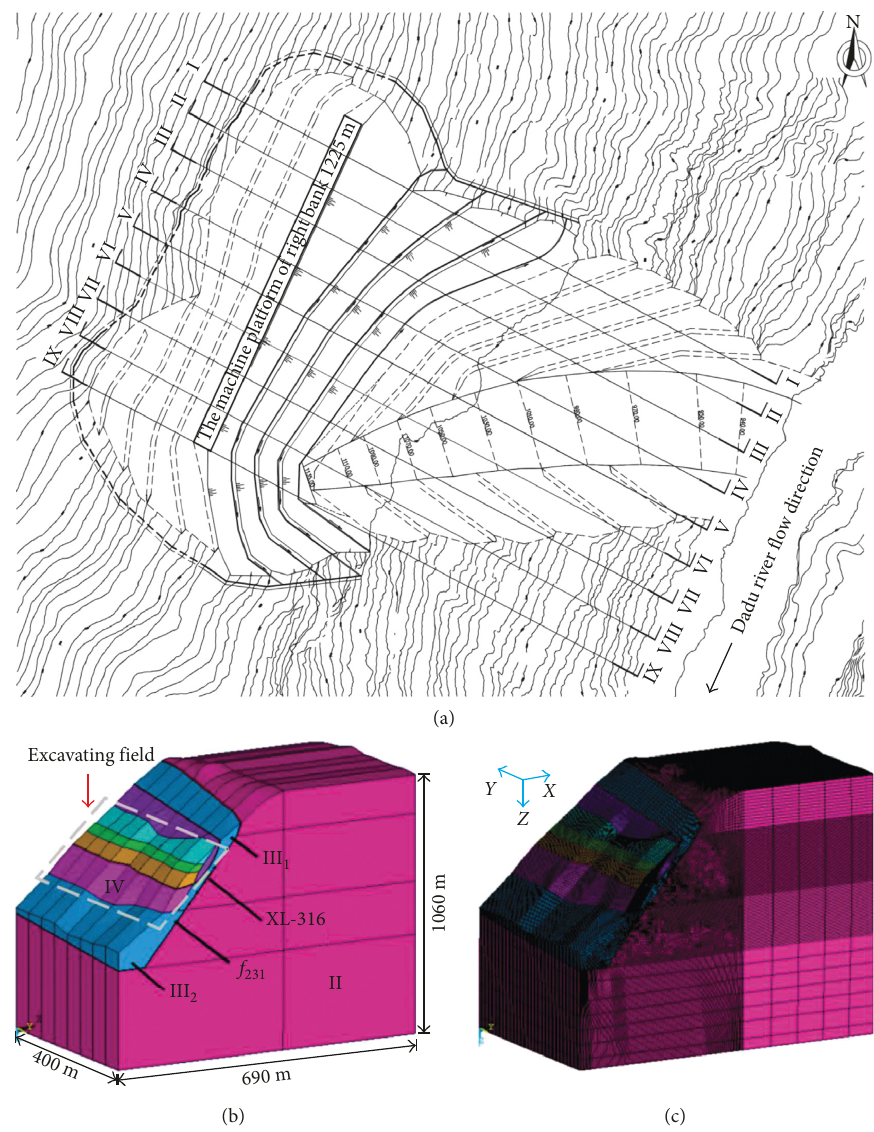
Figure 12: Three-dimensional numerical model and location of the main faults generated by RFPA 3D : (a) excavation design of the right bank slope; (b) physical model; (c) FEM model (the different colours in the figure indicate different mechanical parameters, such as the elastic modulus and compression strength of the rock mass).